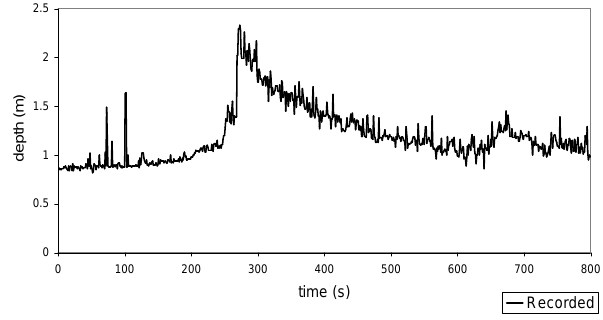
Fig. 4. Upstream lymnograph of the debris flow occurred on 23 July